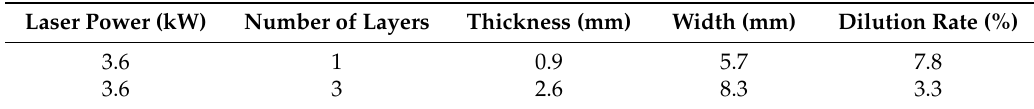
Figure 4. ( a ) OM microstructure of the monolayer and ( b ) trilayer coatings. 3.3. XRD Analysis The X-ray diffraction results of laser cladding coatings are shown in Figure 5. The results show that the main phases of coatings are composed of γ-(Ni, Cr, Fe) solid solution, Fe 3 Ni 3 B, B(Fe, Si) 3 , CrB and laves phase. The characteristic peaks of the two patterns have slightly differences. Laves phase is always segregated at the interdendritic regions as a complex topological structure of AB 2 . It can be reasonably deduced that the regions with light color in interdendritic regions are laves phases combined with the relevant XRD patterns [19]. The fractions of each phase in the coatings can be indicated by the intensity of their characteristic peaks. The trilayer coatings have stronger intensity of CrB and laves phase. Therefore, the laves phase at the interface region of coatings increases with the increase of layer number.